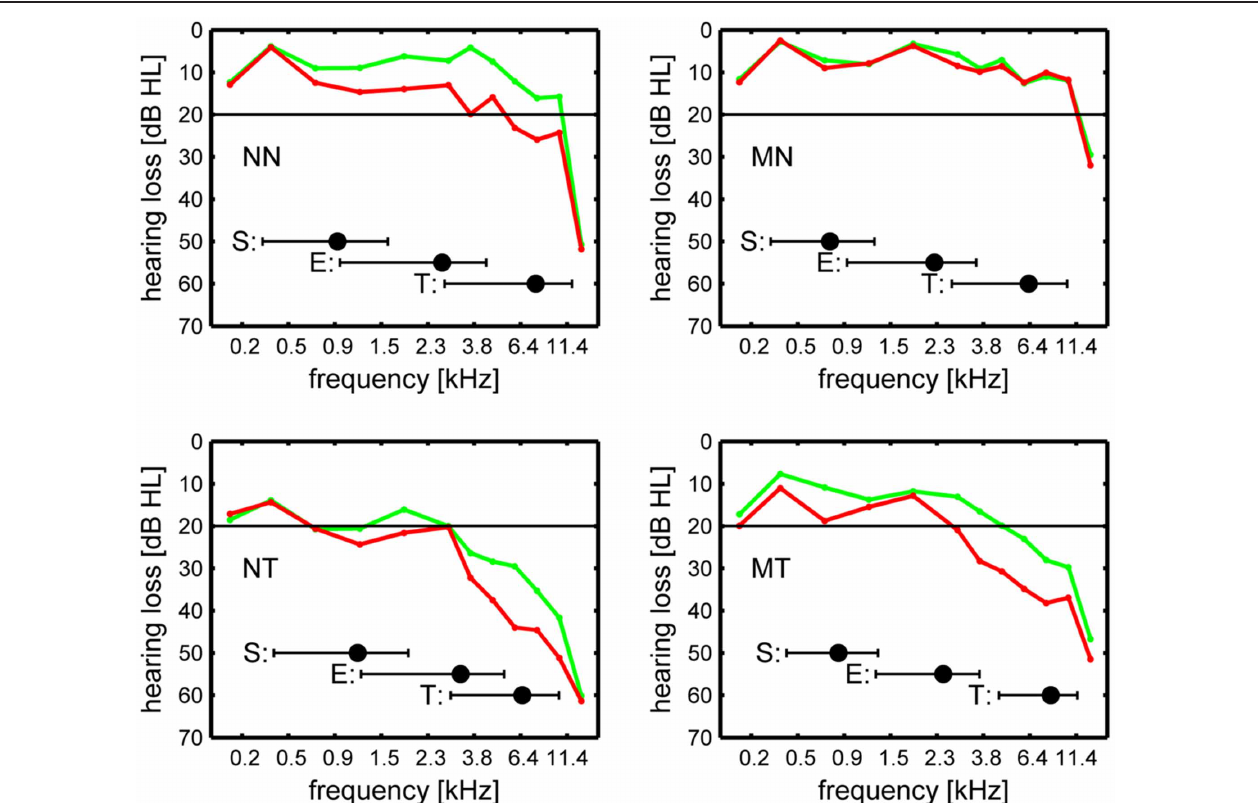
FIGURE 1 | Hearing loss, in dB HL, in the stimulated ear (red line) and the non-stimulated ear (green line). The inset bars show mean and standard deviation of the individually adjusted stimulus carrier frequencies for